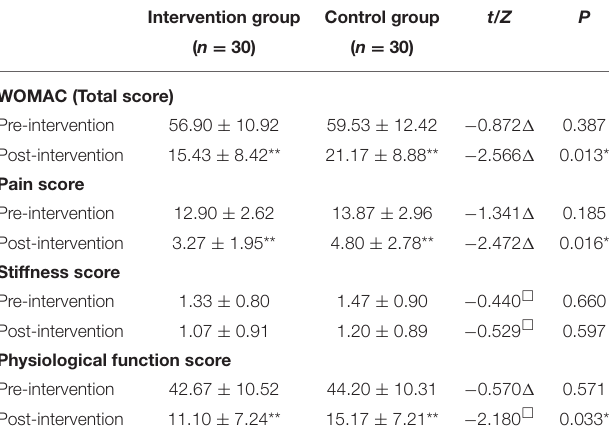
TABLE 6 | WOMAC score measure between groups (x ± s).